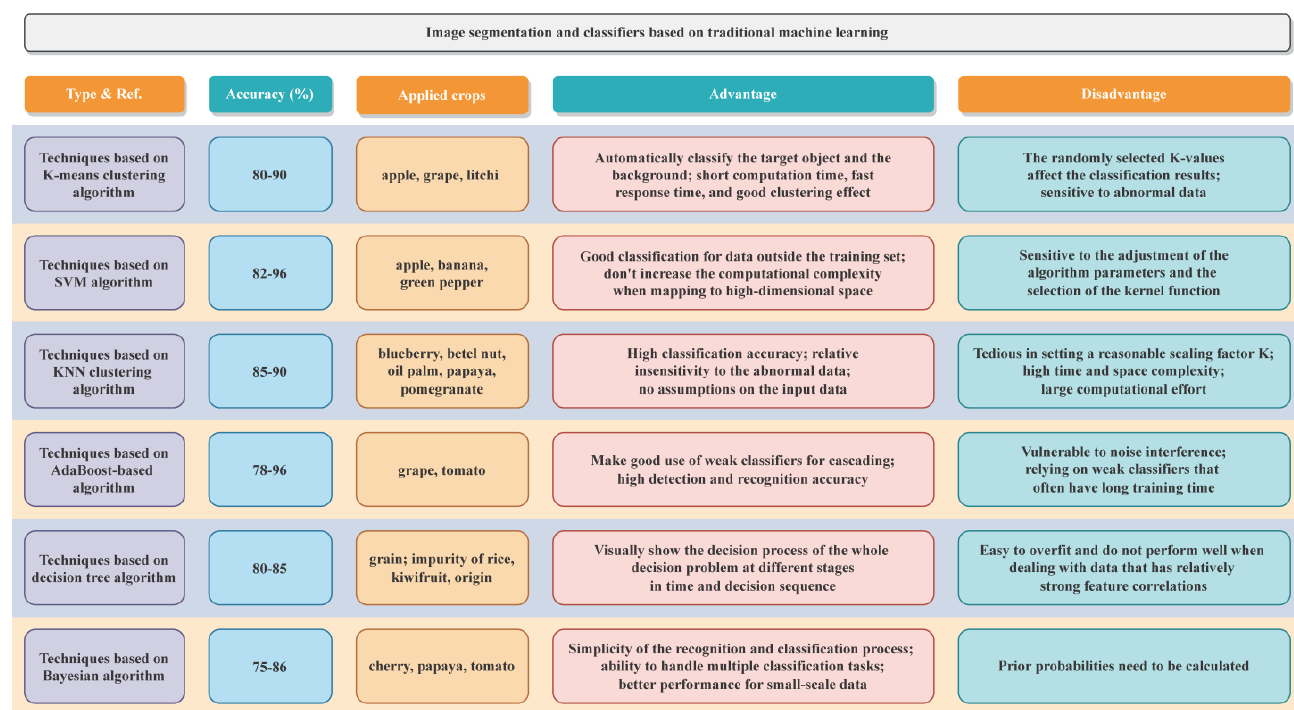
Figure 9. The idea of image segmentation and classifiers based on traditional machine learning.